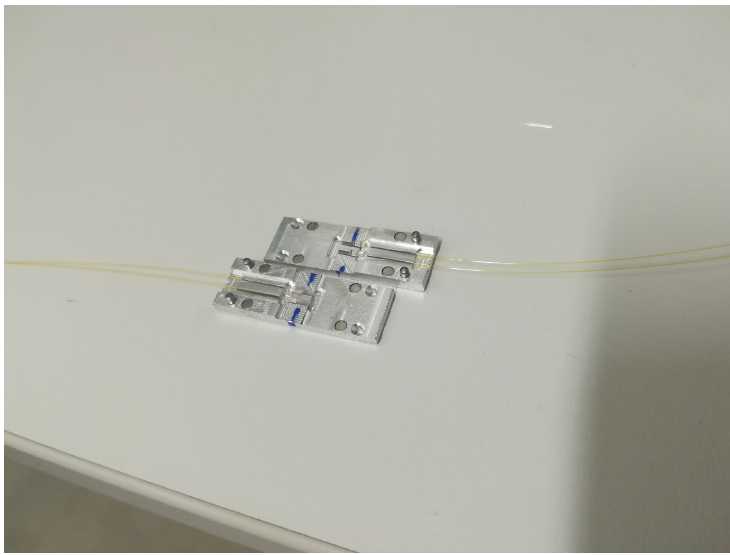
Figure 5. Semifinished connector product.